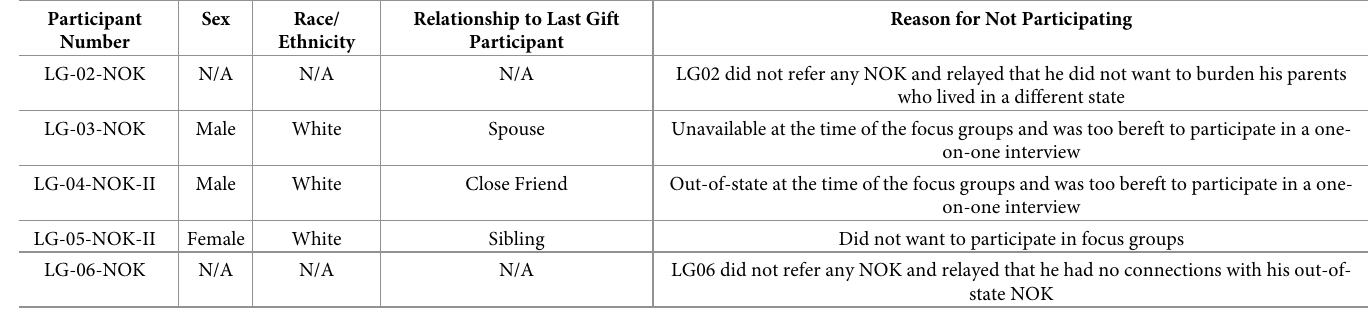
Table 3. Reasons NOK/loved ones did not participate in focus groups or one-on-one interviews (using the focus group guide). Participant